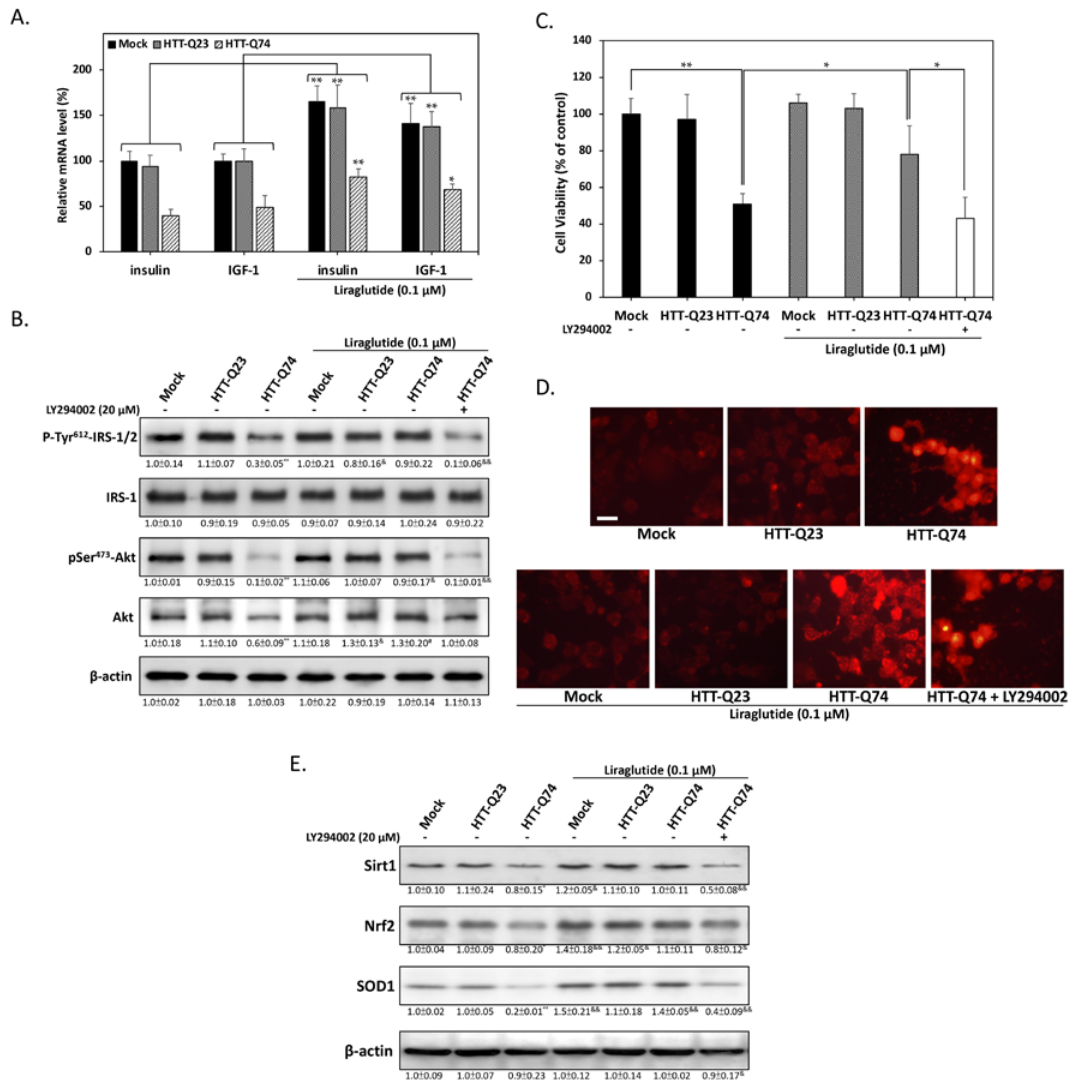
Figure 3. Liraglutide protects against HTT-Q74-induced cell death by restoring insulin signaling. ( A ) Cells were treated for 48 h with or without 0.1 μM liraglutide. The mRNA levels of insulin and IGF-1 were measured through real-time qPCR; ( B ) Immunoblotting revealed that the phosphorylation of Tyr 612 -IRS-1/2 and Ser 473 -Akt was inhibited by 48 h of HTT-Q74 overexpression, and this inhibition was effectively restored by liraglutide; ( C ) Cell viability was determined through MTT assay. The neuroprotective effects of liraglutide were abolished by cotreatment with LY294002 (20 μM), a specific inhibitor of PI3-kinase; ( D ) Dihydroethidium staining results viewed under fluorescence microscopy and showing that liraglutide reduces HTT-Q74-induced intracellular ROS accumulation; ( E ) Levels of some antioxidant signaling-related proteins, including Sirt1, Nrf2, and SOD1, analyzed through Western blot analysis. Liraglutide treatment effectively restored the inhibitory effects of this antioxidant pathway. At least three independent experiments were performed, and values are presented as mean ± SEM. Significant differences were determined through multiple comparisons with Dunnett’s posthoc test for * p < 0.05 and ** p < 0.01 compared with mock groups, and & p < 0.05 and && p < 0.01 compared with HTT-Q74 overexpression groups. Scale bar represents 10 μm.